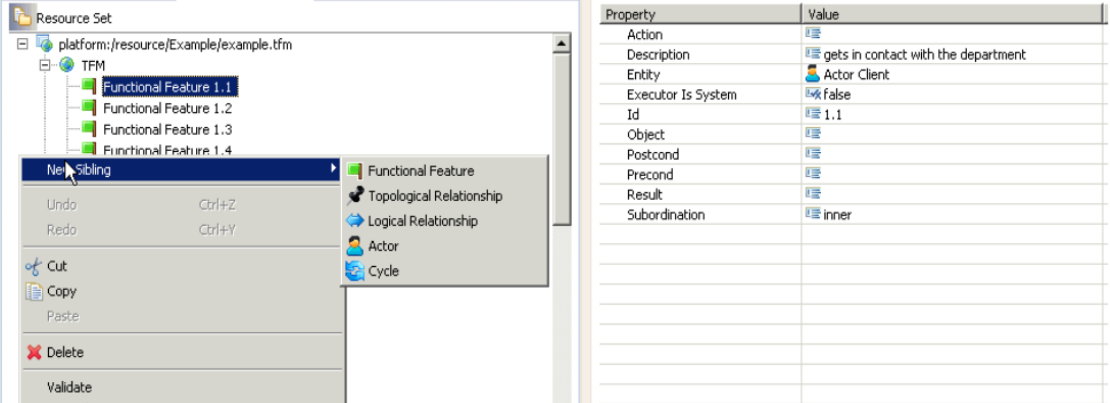
Fig. 3. General view of the TFM